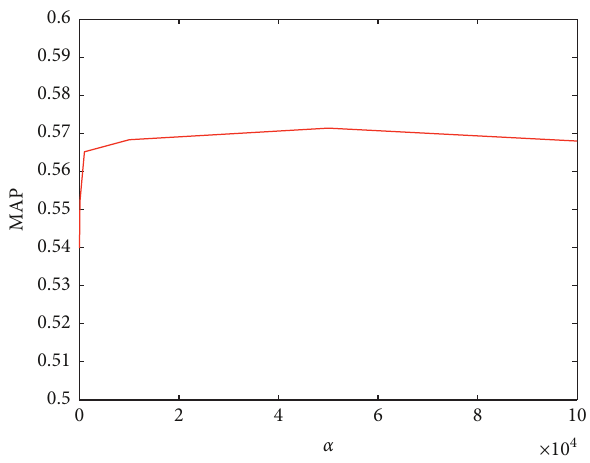
Figure 4: MAP variations with different values of α